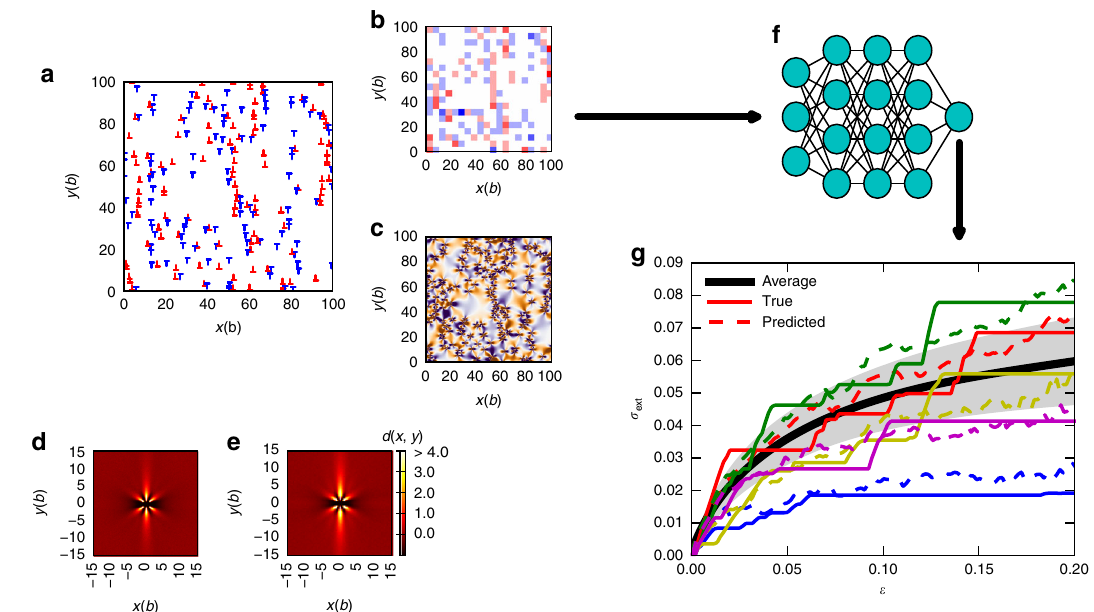
Fig. 1 Machine learning plastic deformation. Using features of the initial dislocation con fi guration ( a ) (with red and blue symbols corresponding to positive and negative Burgers vectors, respectively), such as the density of geometrically necessary dislocations (depicted in ( b ), with red and blue corresponding to positive and negative values of ρ GND , respectively) or the internal stress fi eld (in ( c ), orange corresponding to positive and purple to negative σ sf ), and considering as initial states relaxed random con fi gurations (basic, with the dislocation pair correlation function in ( d )), as well as pre-deformed dislocation con fi gurations (ID, ( e )), we train a neural network (a schematic is shown in ( f )) to infer the relation between features of the initial dislocation con fi gurations and the ensuing stress-strain curves. Examples of the true (solid lines) and predicted (dashed lines) curves for a few basic samples, along with the average (thick black line) and standard deviation (shaded region) of the true stress-strain curves are shown in ( g ). All the fi gures are from systems with 400 initial